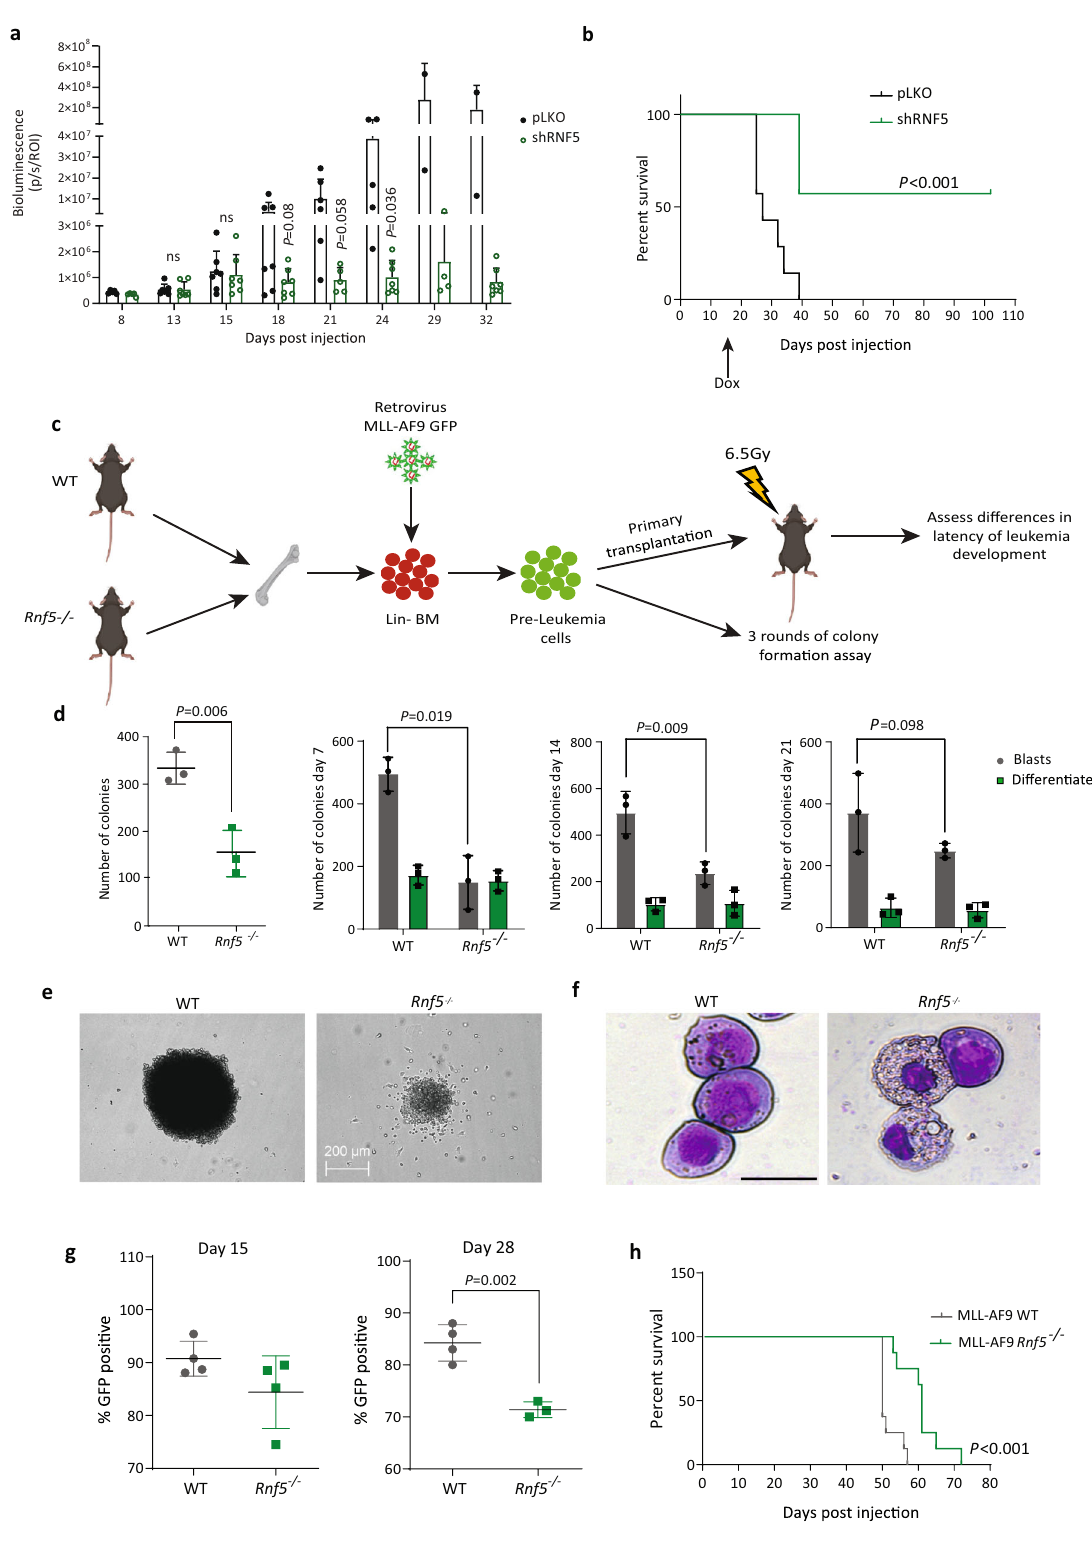
that RNF5 does not induce K63 ubiquitination of RBBP4 single type homotypic chain. We then monitored changes in (Supplementary Fig. 6f). To assess the linkage-speci fi c poly- Myc-tagged RBBP4 ubiquitination in cells overexpressing Flag- ubiquitin induced by RNF5 on RBBP4, we used mutant HA- tagged RNF5. Poly-ubiquitination of RBBP4 was enhanced by ubiquitin constructs with only one lysine available for linkage (K- RNF5 only in the presence of K29 ubiquitin (Fig. 6h), strongly only mutants: K29, K11, K27, K6, and K33) in which all lysine suggesting that RNF5 induces K29-topology polyubiquitination residues except that indicated are mutated to arginine allowing a of RBBP4. NATURE COMMUNICATIONS| (2021) 12:5397